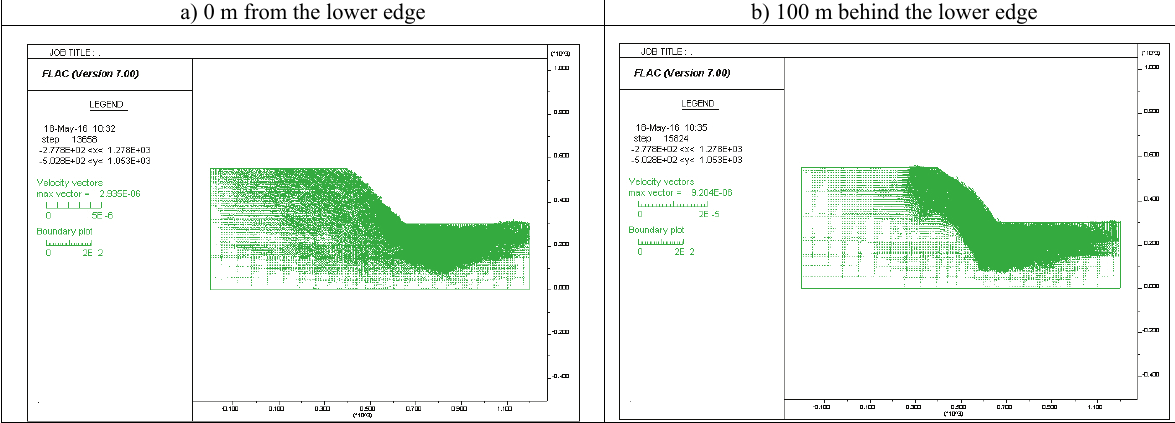
Fig. 19. Plastic indicator at particular stages of the longwall operation proceeding from the right side towards the lower edge of slope (measured point is the face of the longwall panel) (Note: violet color shows tension failure while red color shows shear failure) a) 0 m from the lower edge